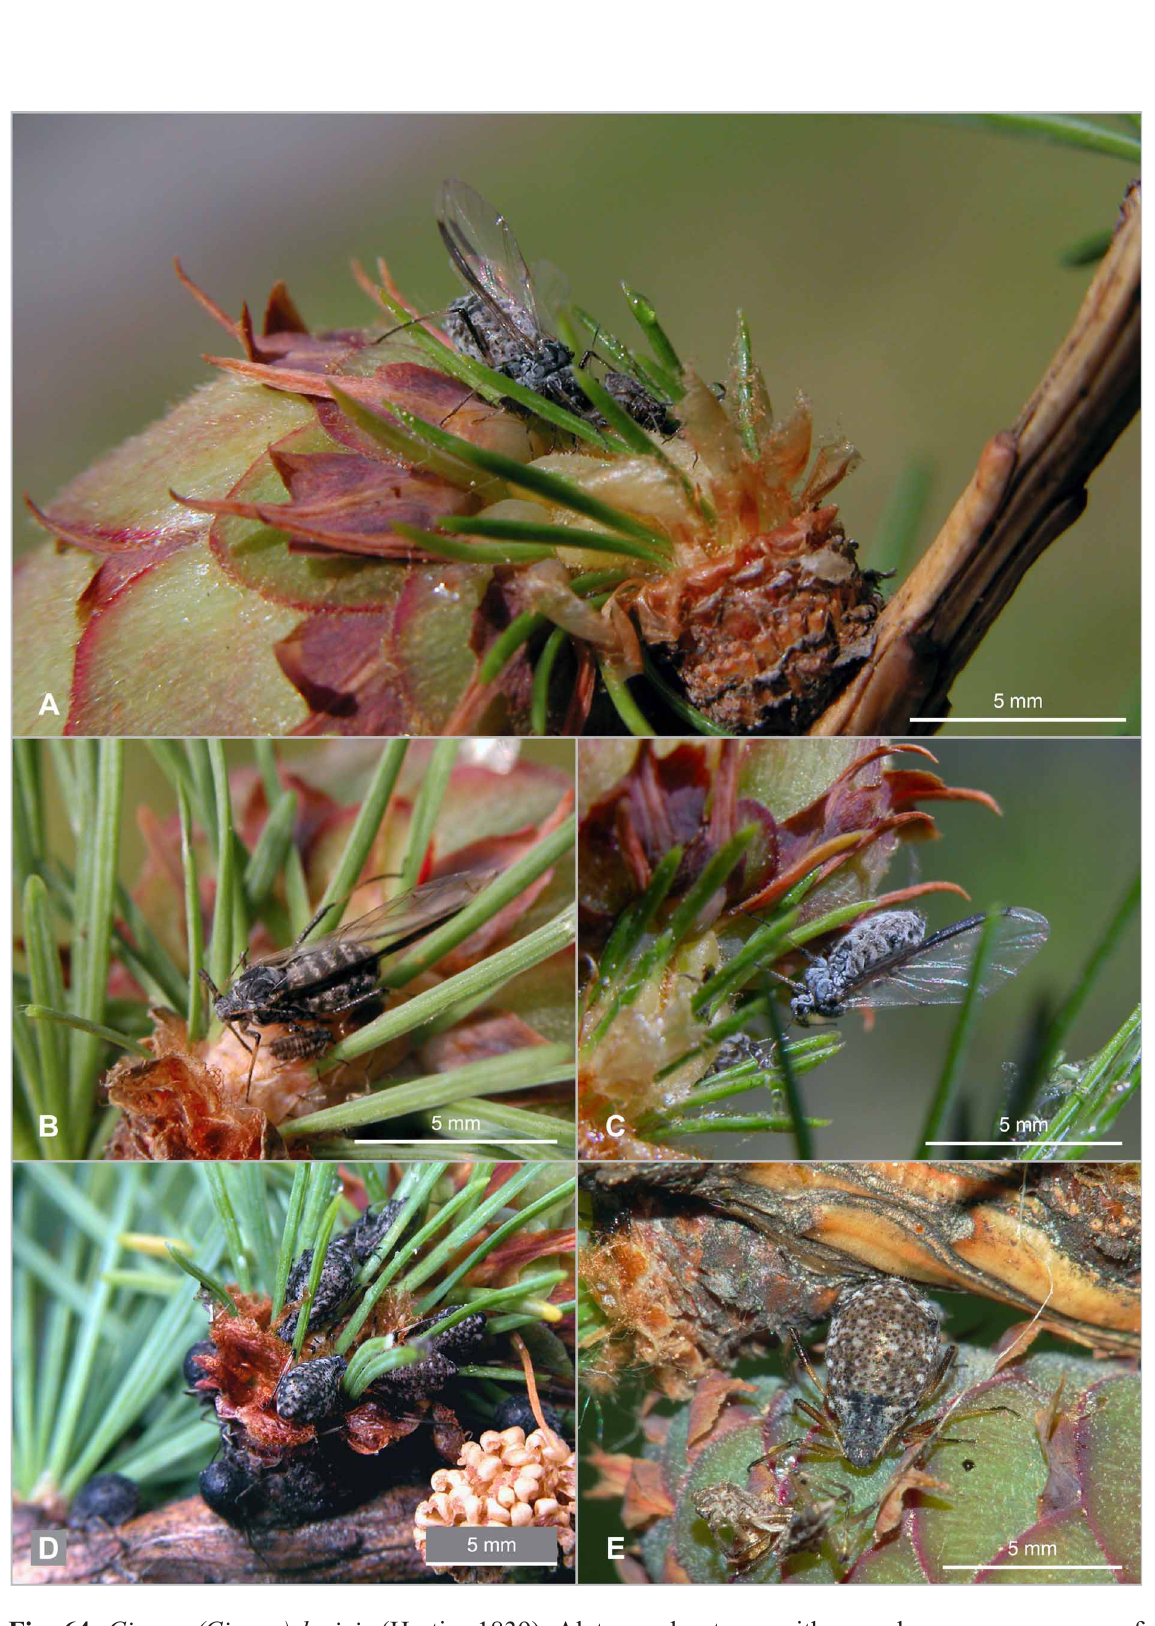
Fig. 64. Cinara (Cinara) laricis (Hartig, 1839). Alatae and apterae with nymphs on young cones of Larix decidua . Note the wax-powdered venter (in